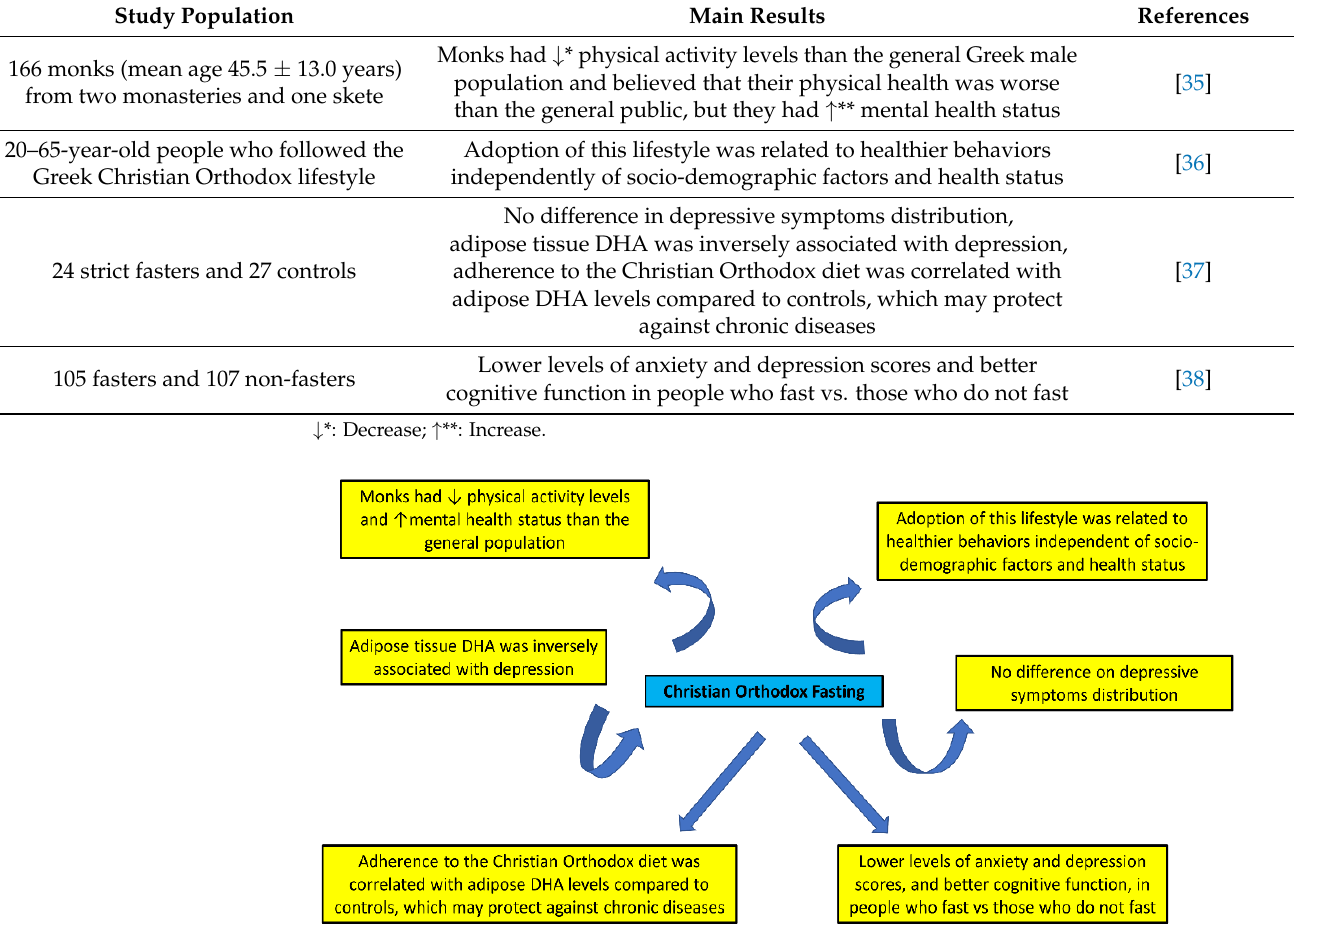
Table 4. Studies concerning the impact of Christian Orthodox fasting on well-being. Study Population